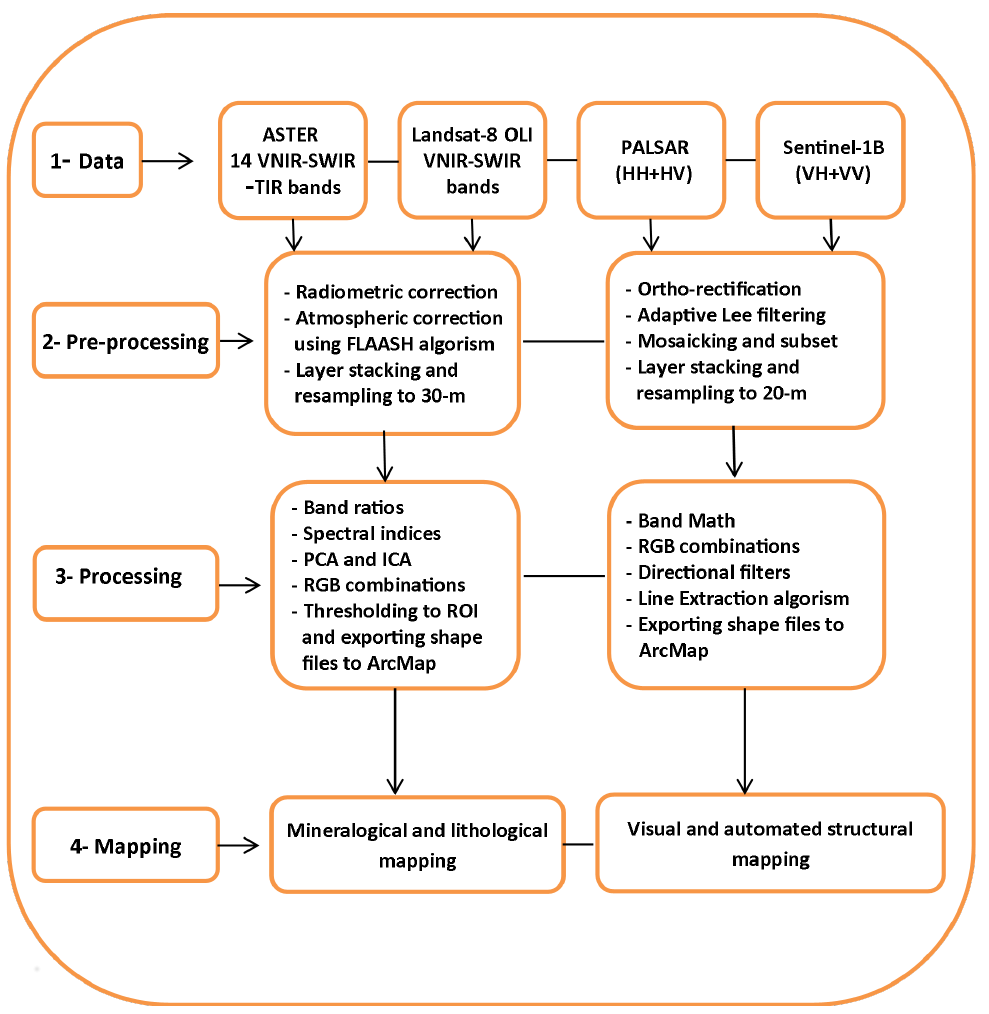
Figure 3. Flowchart of methods and data types and the succession of processing steps applied for the present